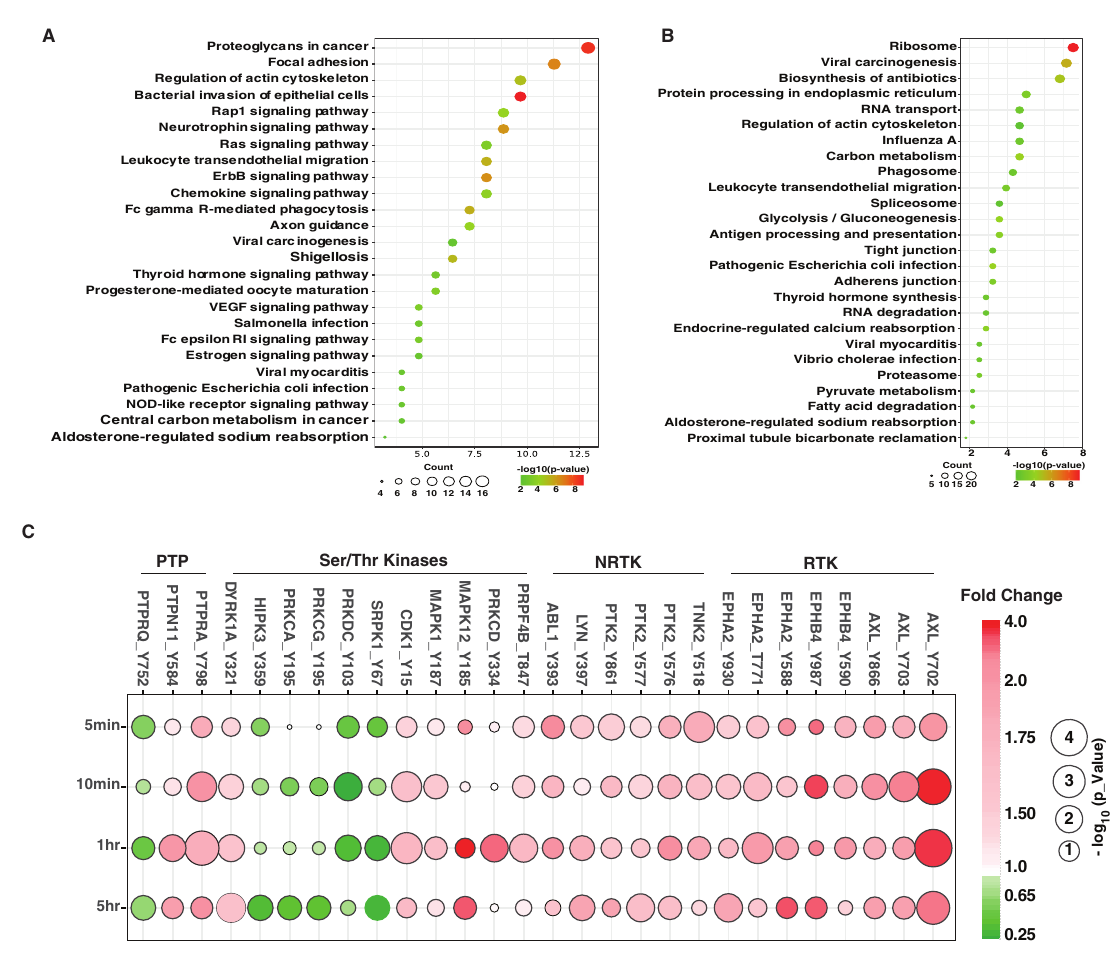
Figure 4. Signaling pathways activated by AXL. ( A , B ). Enriched signaling pathways for proteins with upregulated ( A ) or downregulated ( B ) tyrosine phosphorylation. Pathway analysis was performed using DAVID [29] based on the KEGG [42] pathway database and replotted using an R package. The size of the circle represents the number of proteins identified in each pathway. The color scheme represents − log 10 ( p -value) as indicated. ( C ). Bubble plot displaying the alterations in tyrosine phosphorylation of protein tyrosine phosphatases (PTP), serine/threonine kinases, non-receptor tyrosine kinases (NRTK) and receptor tyrosine kinases (RTK). The color scheme represents the fold-changes upon GAS6 treatment of individual tyrosine phosphosites at the indicated time points. The size of the circle represents − log 10 ( p -value) compared to untreated MDA-MB-231